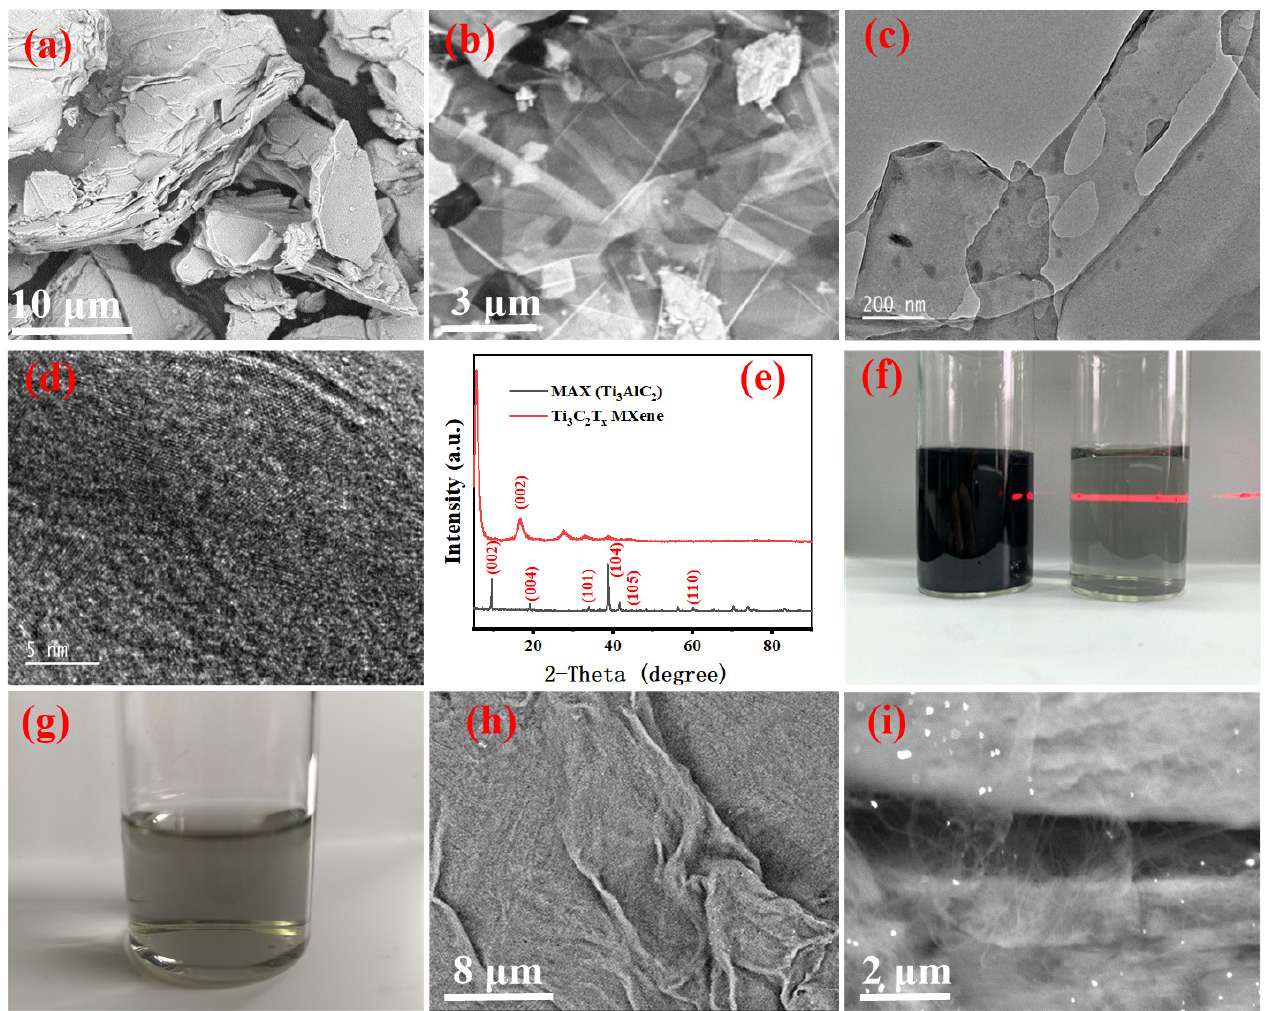
Figure 2. Scanning electron microscopy (SEM) images of MXene ( a ) before and ( b ) after ultrasound; ( c ) transmission electron microscopy (TEM) image of MXene; ( d ) high-resolution (HR)-TEM image of the flake edge of the MXene membrane; ( e ) X-ray diffraction (XRD) patterns of MAX and MXene; ( f ) Tyndall effect of MXene suspension before and after dilution; ( g ) photograph of diluted SWCNTs dispersed in the SDBS solution; SEM images of SWCNTs ( h ) before and ( i ) after dispersion.